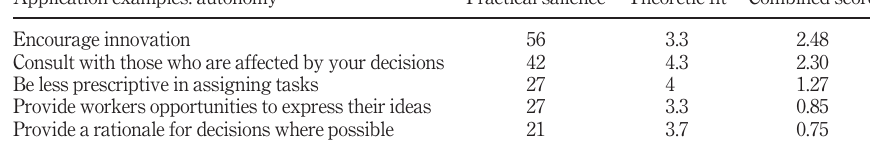
Table 1. How leaders support followers ’ basic psychological need for autonomy in the